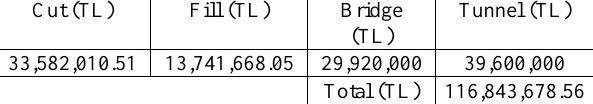
Table 13. Approximate total cost of improving the conventional line on rolling